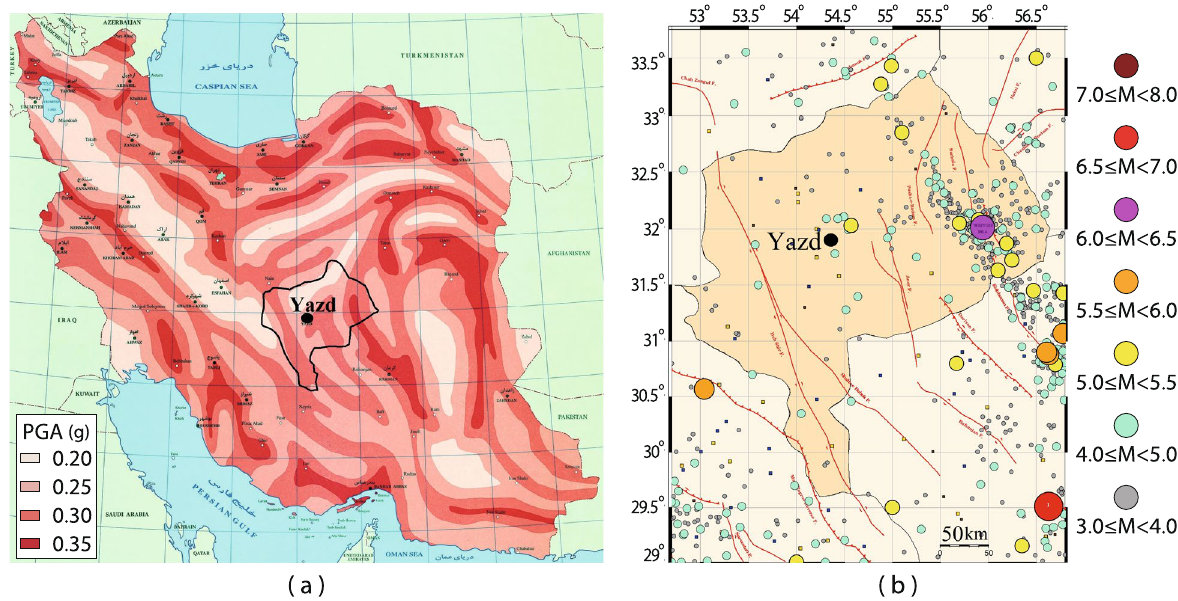
Fig. 3 Seismicity of Yazd province: a seismic hazard zonation map of Iran (Source: IIEES 2017), with the limits of Yazd province, highlighted in black; b earthquake epicentres and major faults of Yazd province and neighbouring areas (Source: Dezvareh et al. 2017)